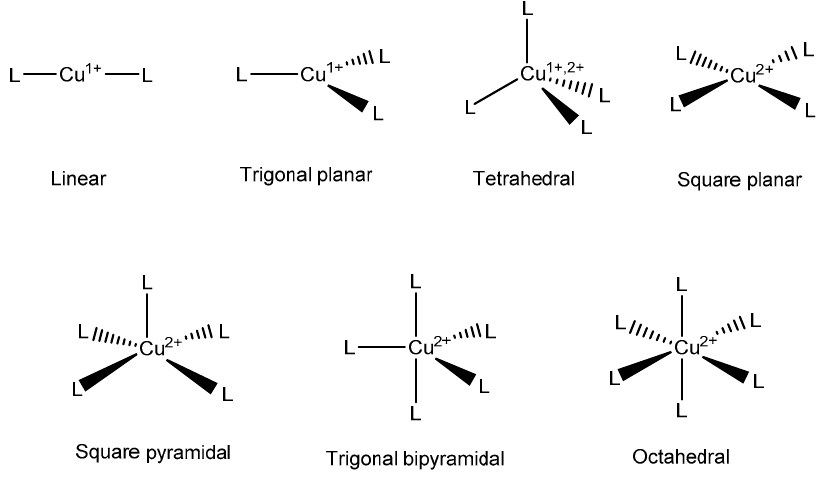
Figure 3. Typical geometries for Cu(I) and Cu(II) chelation.